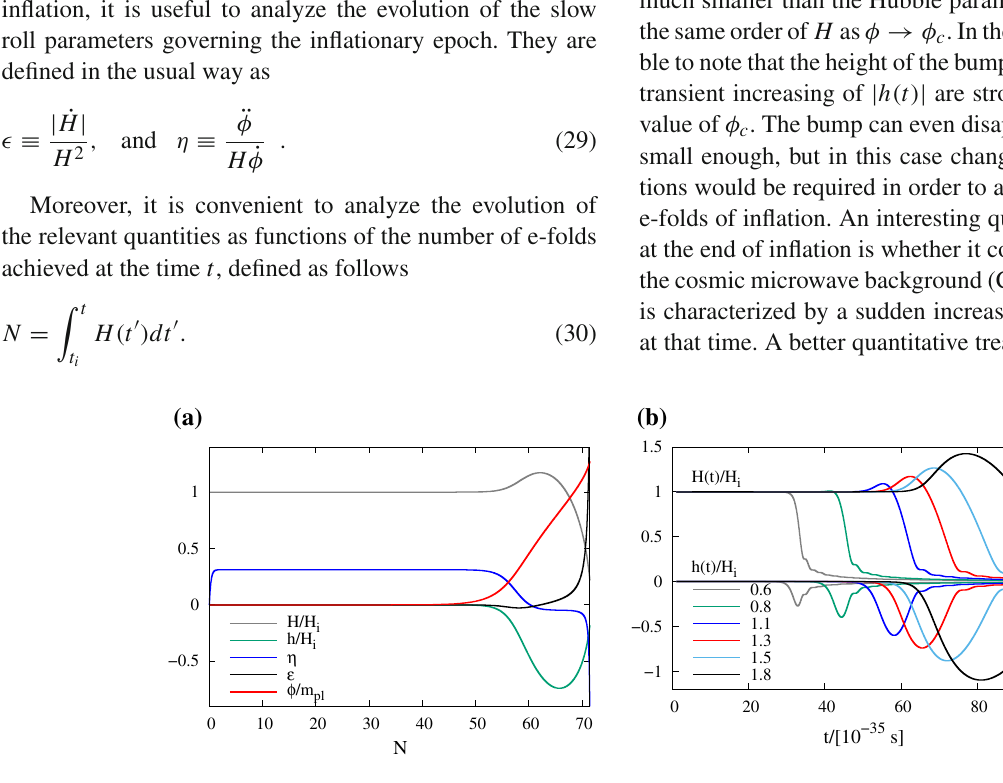
Fig. 2 a Evolution of the Hubble function H , the torsion function h , the slow-roll parameters (cid:16) and η , and of the field φ as functions of the number of e-folds during inflation. When the inflation ends (cid:16) = 1 and we have N (cid:7) 71. All the quantities were obtained using φ c = 1 . 3 m pl .